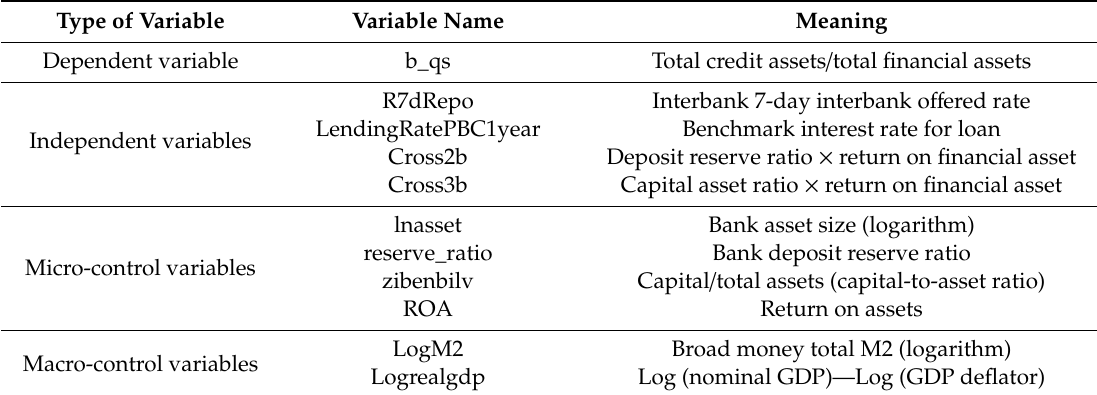
Table 1. Definition of various variables.